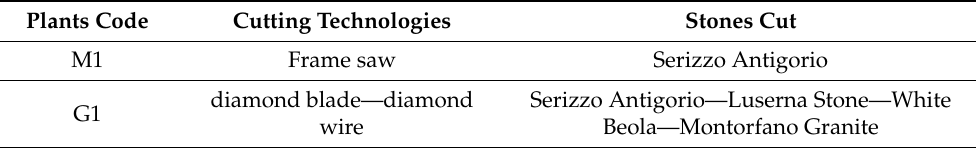
Table 3. Cutting technologies and type of stones cut in two different plants. Plants